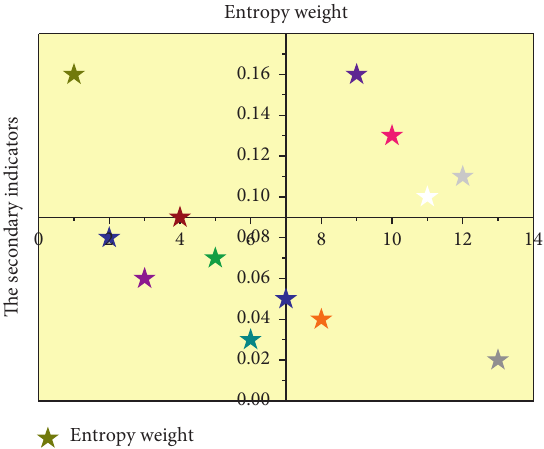
Figure 5: Statistical chart of entropy weight of educational carrying capacity